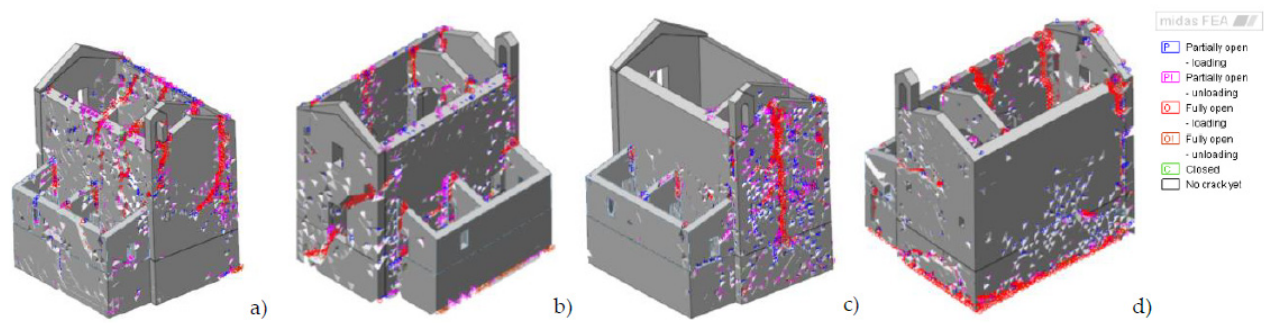
Figure 13. Numerical damage for Sant’Anna Church in Camerino (Macerata, Central Italy) for PushMass + x ( a ), PushMass − x ( b ), PushMass + y ( c ), PushMass − y ( d ).